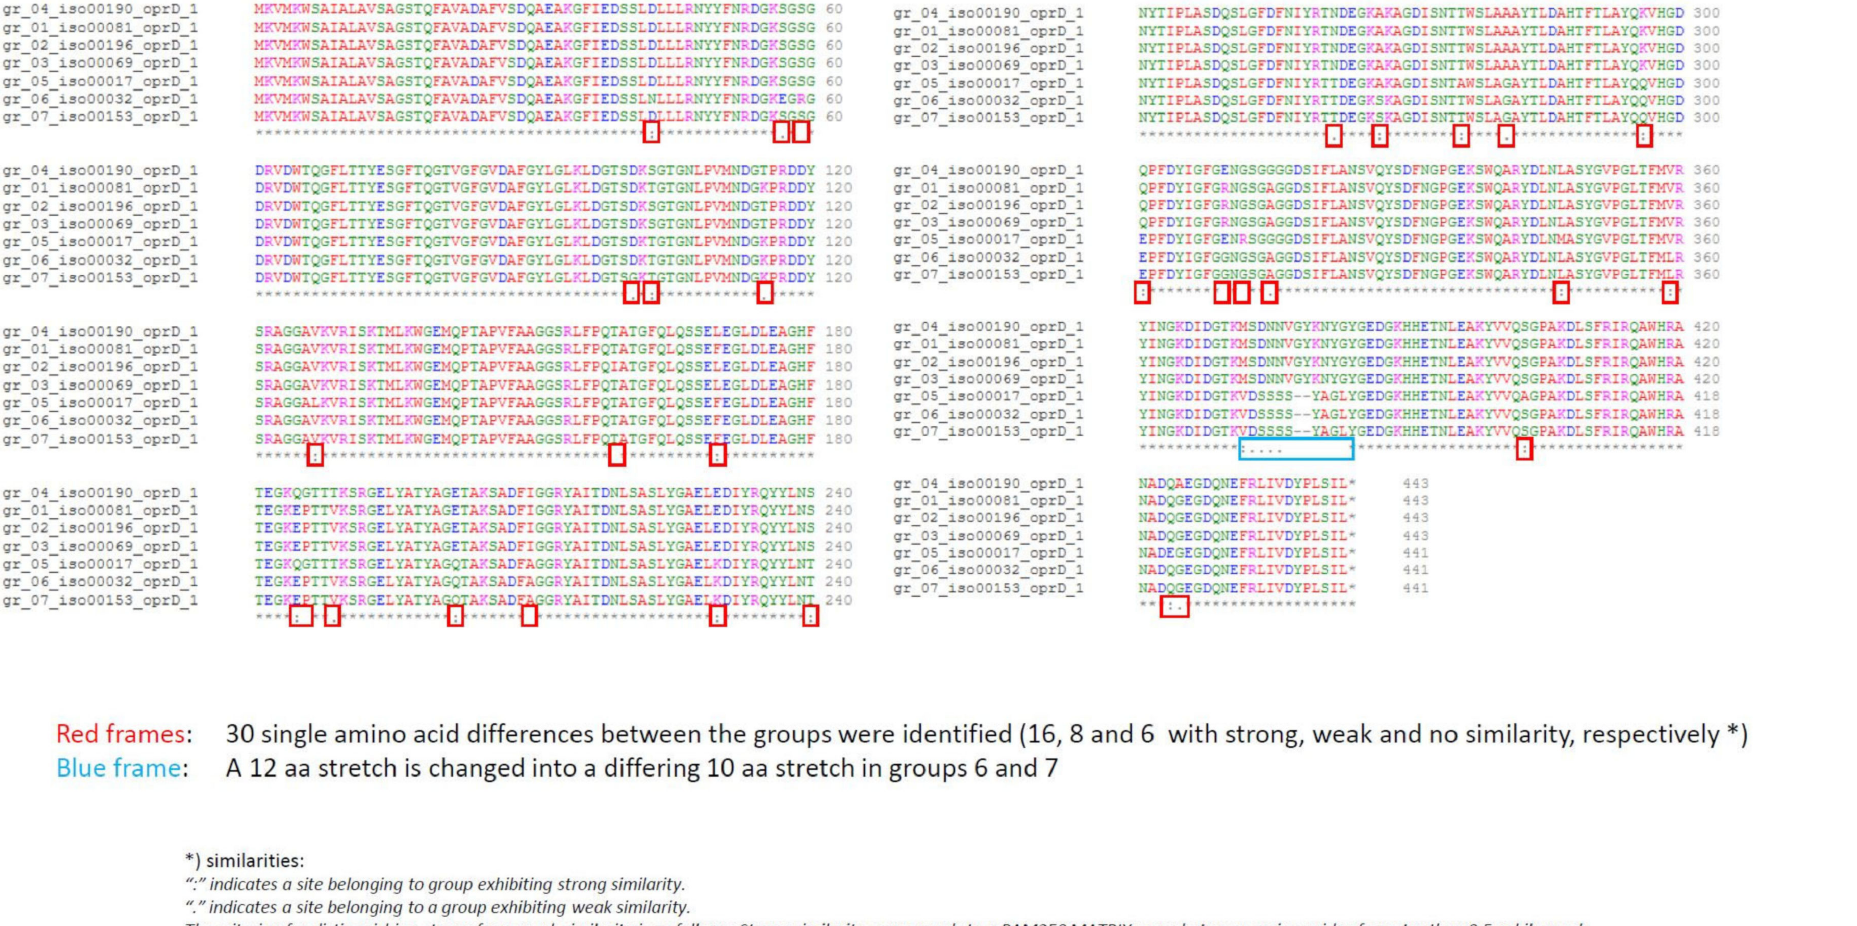
Figure A1. Clustal omega multiple alignment of oprD proteins—one example for the 7 detected